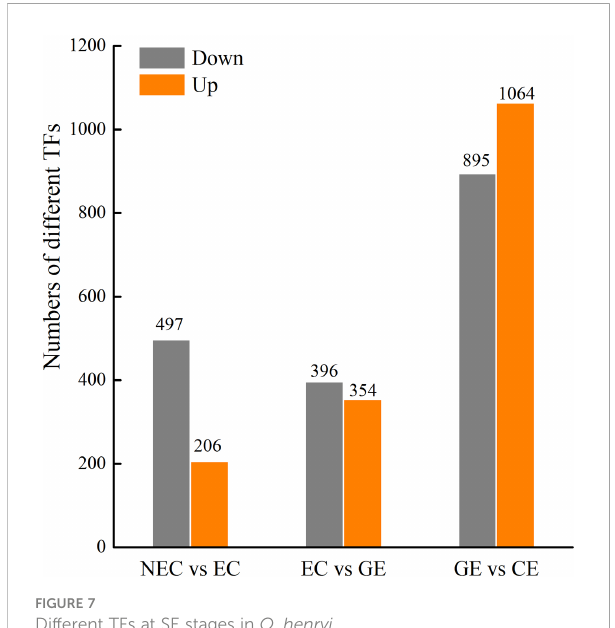
FIGURE 7 Different TFs at SE stages in O. henryi